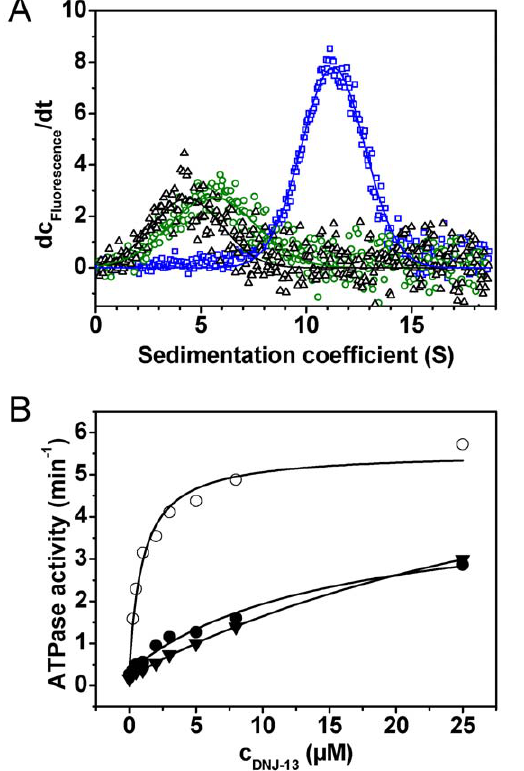
Figure 5. The ternary interaction of CeHsc70 with BAG-1 and DNJ-13 is affected by the lid domain truncations. ( A ) dc/dt plots were generated from sedimentation velocity experiments of 300 nM *DNJ-13 in the absence (black) or in the presence of 3 m M CeHsc70 and 4 mM ATP (blue). The influence of BAG-1 on complex formation was N analyzed by addition of 15 m M BAG-1 to *DNJ-13-CeHsc70-ATP (green). ), CeHsc70- D 512 ( # ) or ( B ) The ATPase activity of 1 m M CeHsc70 ( CeHsc70- D 545 ( . ) was measured with increasing amounts of DNJ-13 in the presence of 2 m M BAG-1 in standard buffer at 25 u C. Data analysis was performed as described in Materials and Methods.